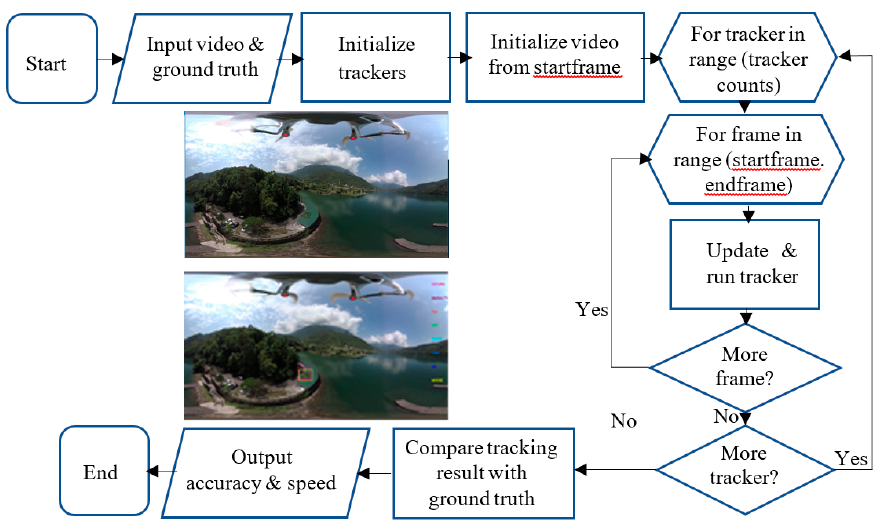
Figure 3. Flowchart of the proposed experiment to evaluate eight trackers on nine 360-degree videos.